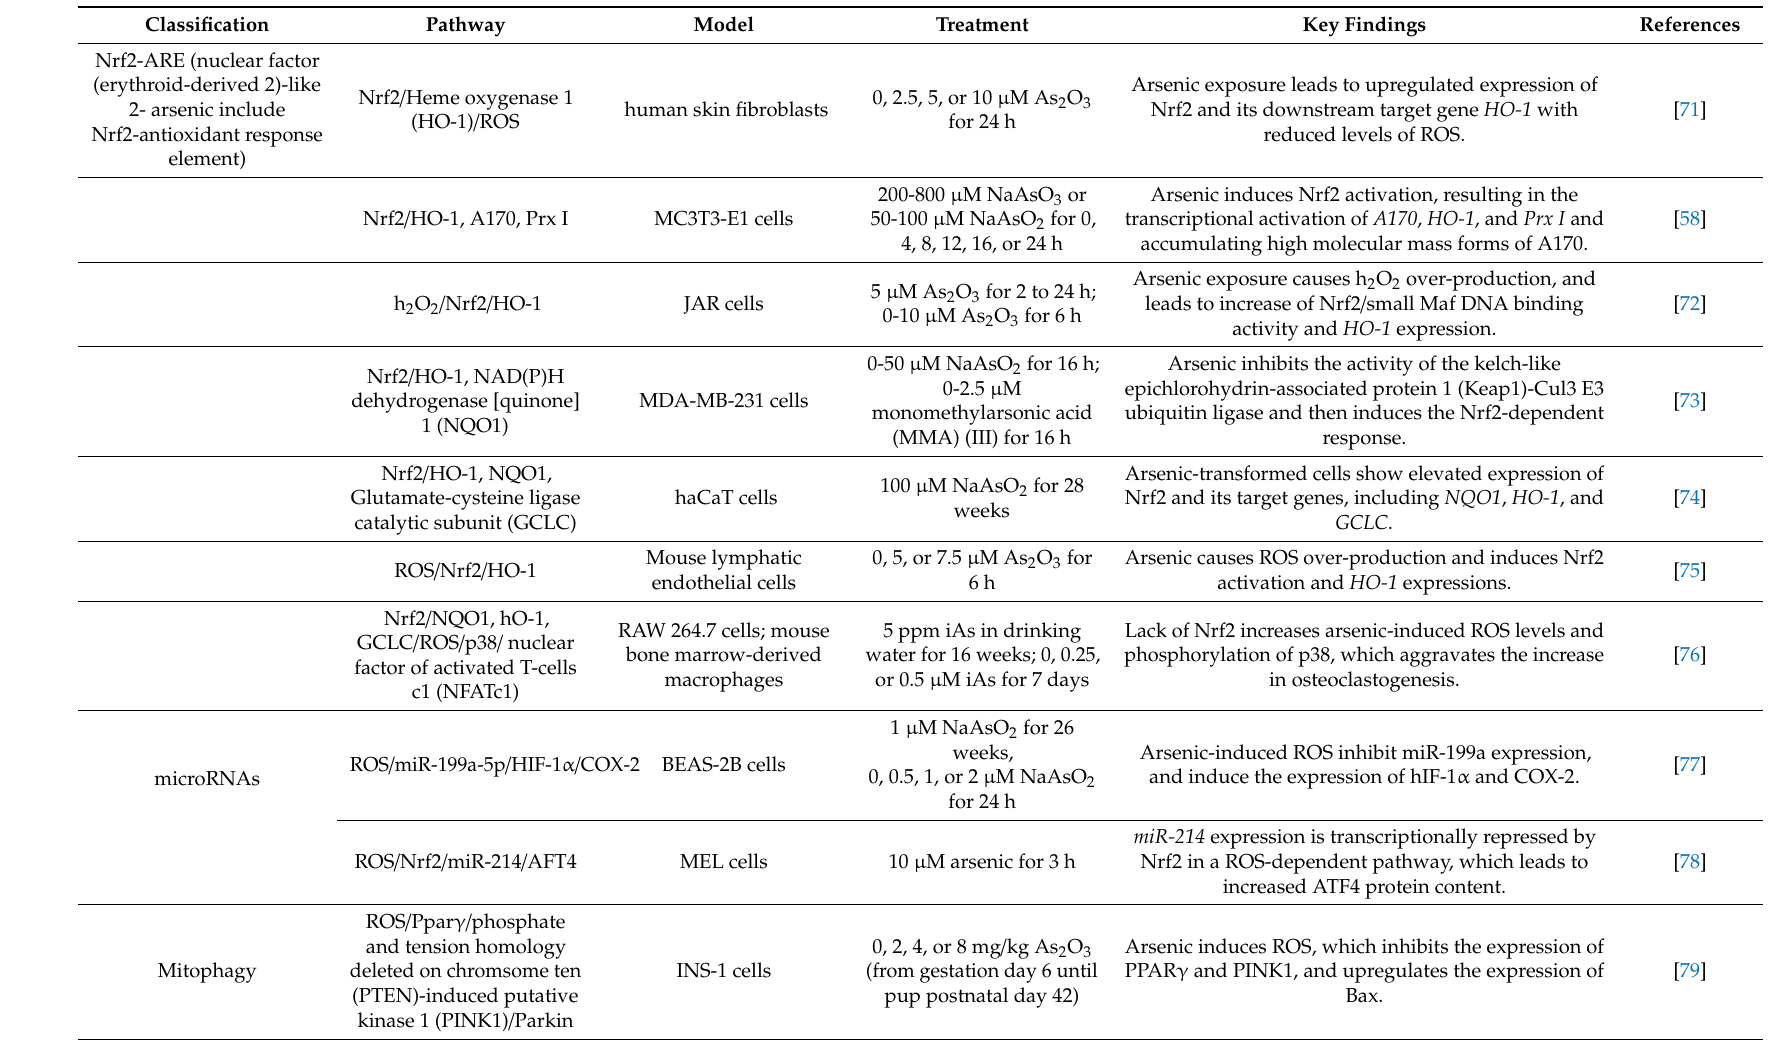
Table 1. Pathways related with ROS in arsenic